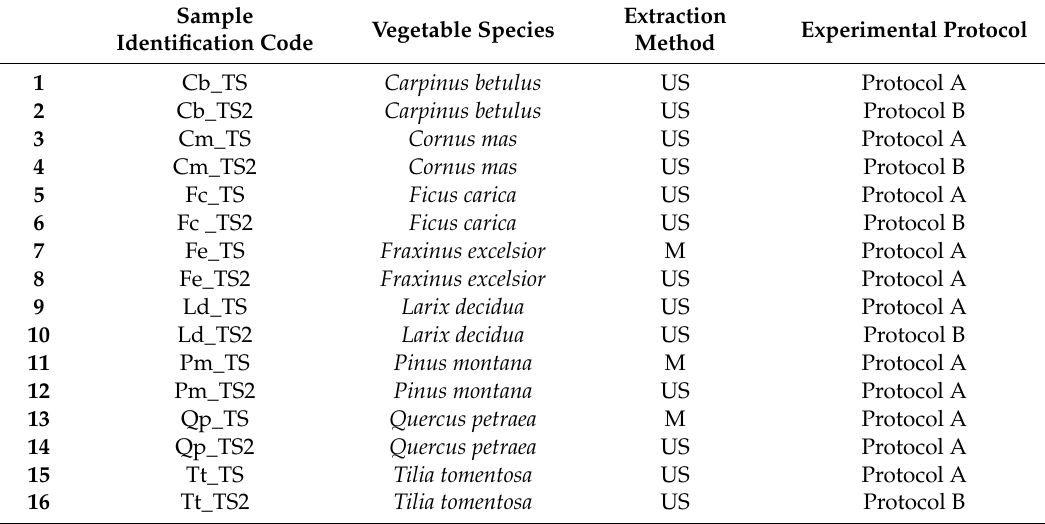
Table 3. External test set. 16 BDs obtained starting from the eight vegetable species using two di ff erent methods (cold maceration M and Pulsed Ultrasound-Assisted Extraction US) and two di ff erent experimental protocol (Protocol A and B) are taken into account as independent set to test the statistical